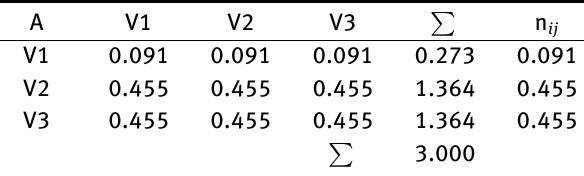
Table 10: Calculation of effectiveness in accordance with deploy-